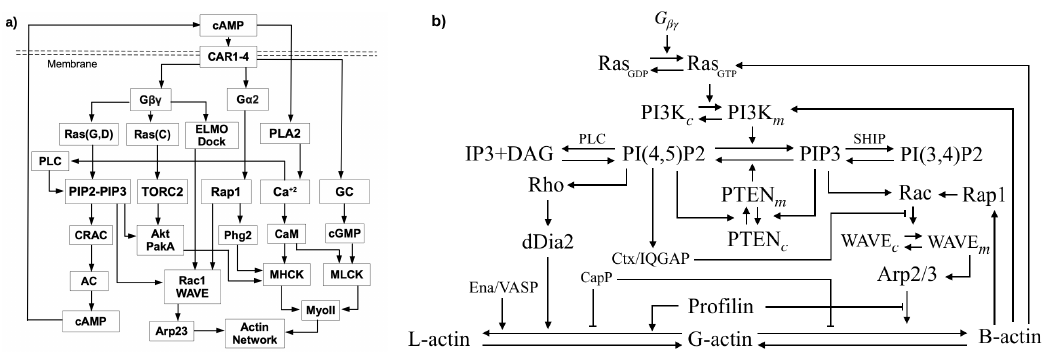
Figure 5. ( a ) The principal pathways in cAMP signal transduction in Dicty. CAR1-4: the cAMP receptors, G α and G βγ : components of the G-protein used for the transduction of the cAMP signal, 2 Ras, Rac1: small GTPases, PIP2 and PIP3; membrane components that are inter-converted via phosphorylation and de-phosphorylation, IP 3 and DAG: products of PIP2 degradation, GC: guanylate cyclase—the enzyme that produces cyclic GMP (cGMP), AC: adenylate cyclase—the enzyme that produces cAMP, Myo-II: a motor protein involved in contraction of the actin network. Arrows indicate an effect, but not whether it is activating or inhibiting, and feedback steps are not shown. ( b ) Details of the PIP2-PIP3